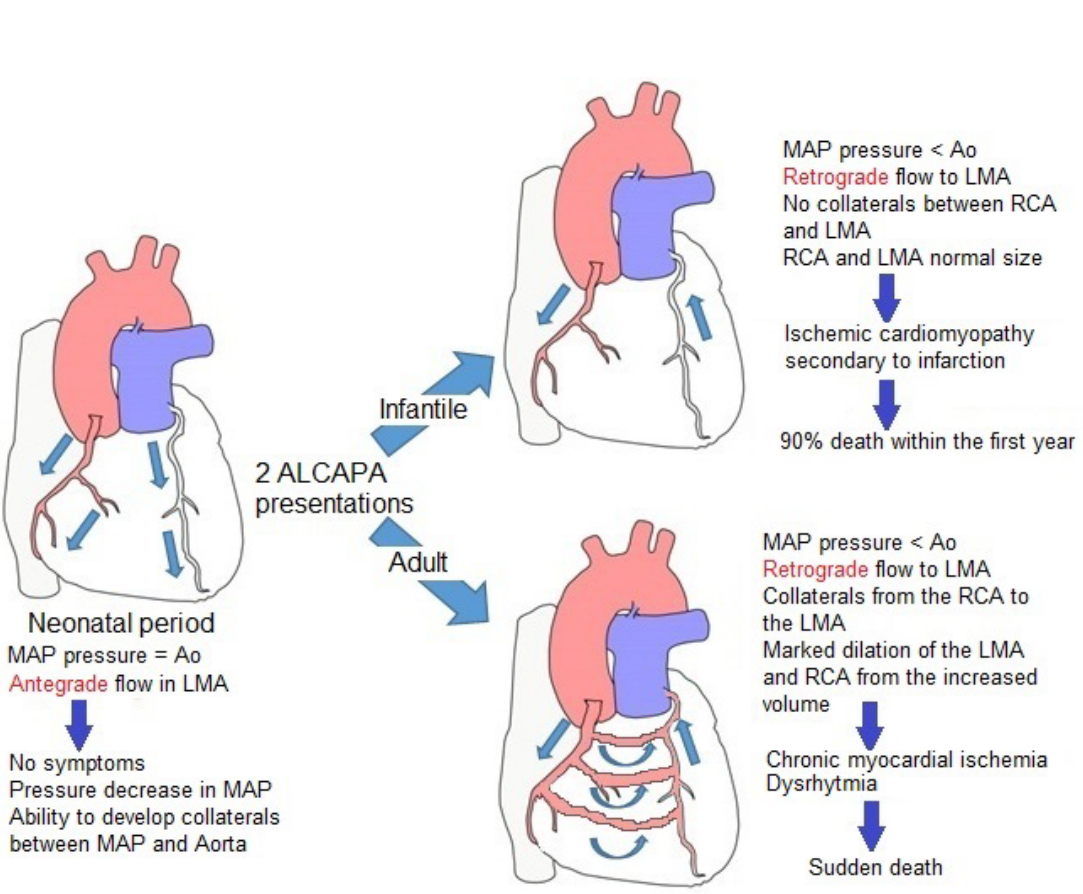
Figure 4. ALCAPA syndrome pathophysiology.